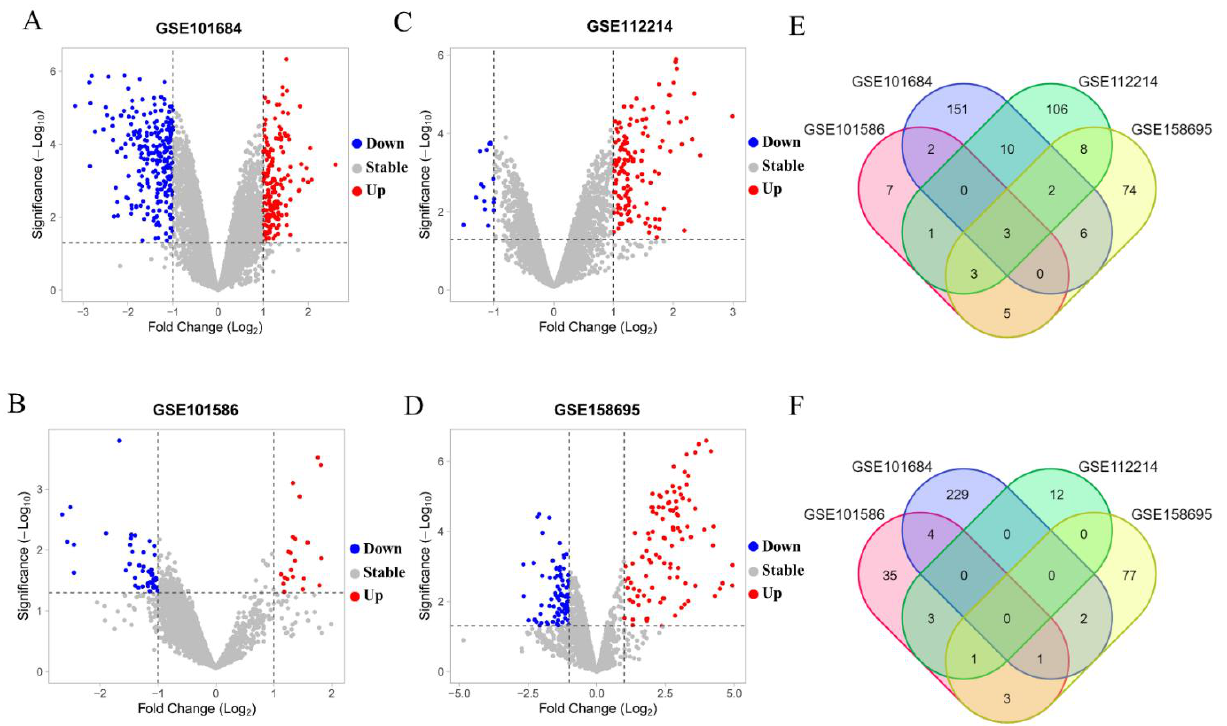
Figure 1. Volcano plots for of differentially expressed circRNAs in LUAD, the red points and blue points represent up and down expressed circRNAs, respectively. ( A ) GSE101684, ( B ) GSE101586, ( C ) GSE112214, ( D ) GSE15869. The eight upregulated circRNAs ( E ) and two downregulated ( F ) circRNAs were identified by intersection of circRNAs from the four databases. Table 2. Differentially expressed circRNAs that overlapped in all above-described GEO datasets.